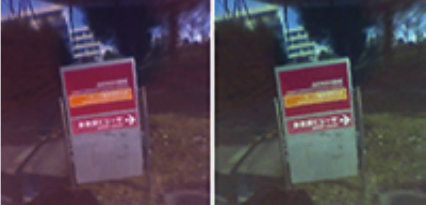
Figure 9 . Result after color correction. The left and right images are the original unwarped corneal image and the color-corrected un- warped image,